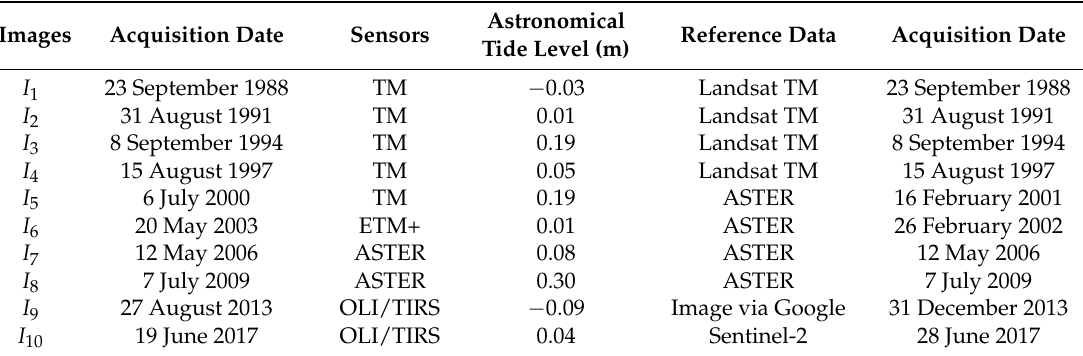
Table 1. Images used in this study and their related reference